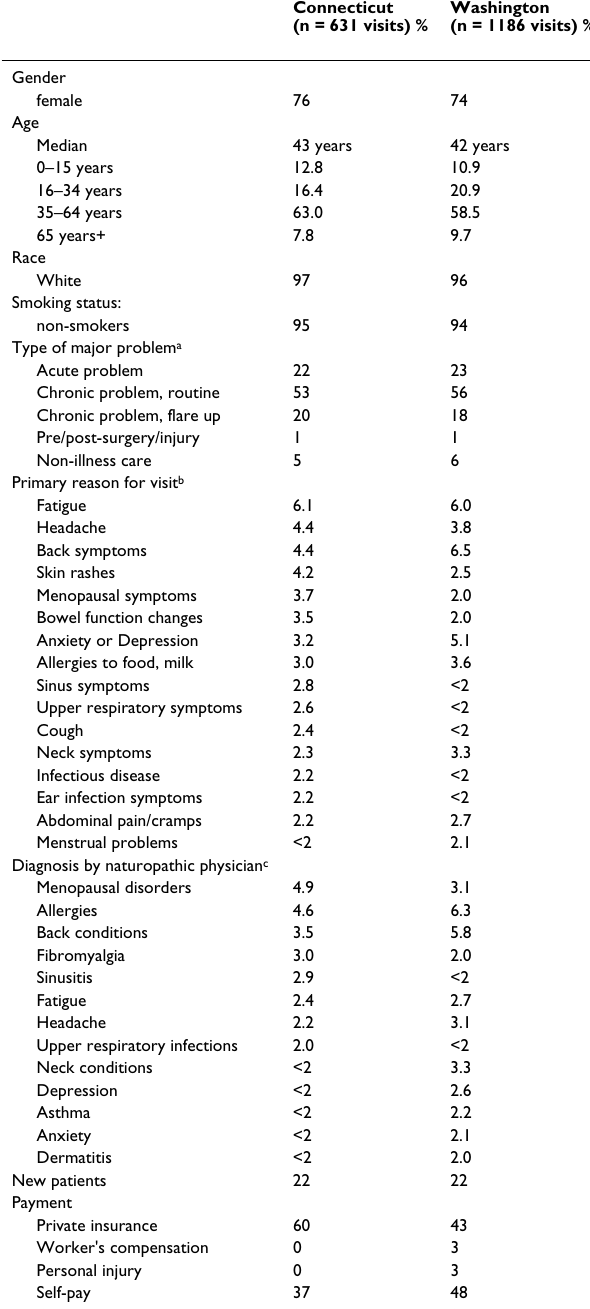
Connecticut Washington (n = 631 visits) % (n = 1186 visits) %